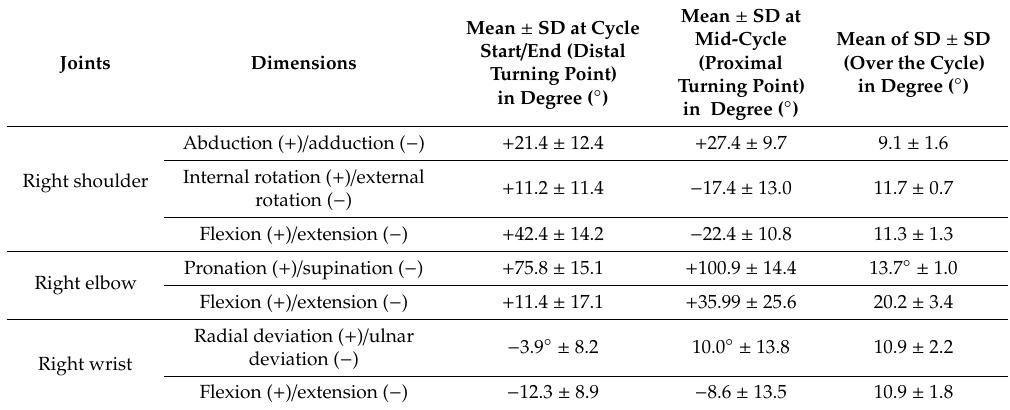
Table 2. Mean values and standard deviations of movements of the right shoulder, elbow and wrist over the course of the